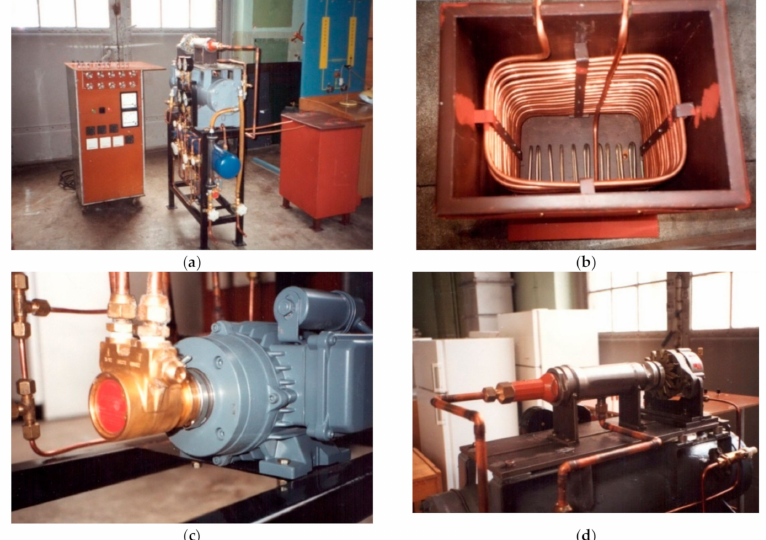
Figure 4. A view of a micro-power ORC test stand implemented in the mid-1990s at the Wrocław University of Technology. ( a ) A general view of the test stand; ( b ) A detailed view of the vapor generator; ( c ) A detailed view of the multi-vane pump with an electric motor; and ( d ) A detailed view of the multi-vane expander and